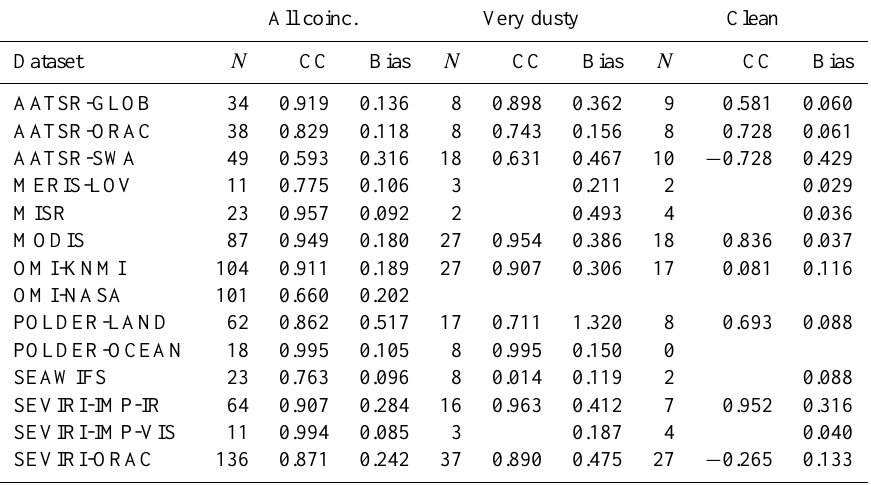
Table 4. Summary of AOD comparisons for three cases: “all”, “very dusty” and “clean” coincidences. “ N ” is the numbers of coincidences, “CC” the correlation coefficient and “bias” is the absolute mean difference between AERONET and satellite AOD. All coinc. Very